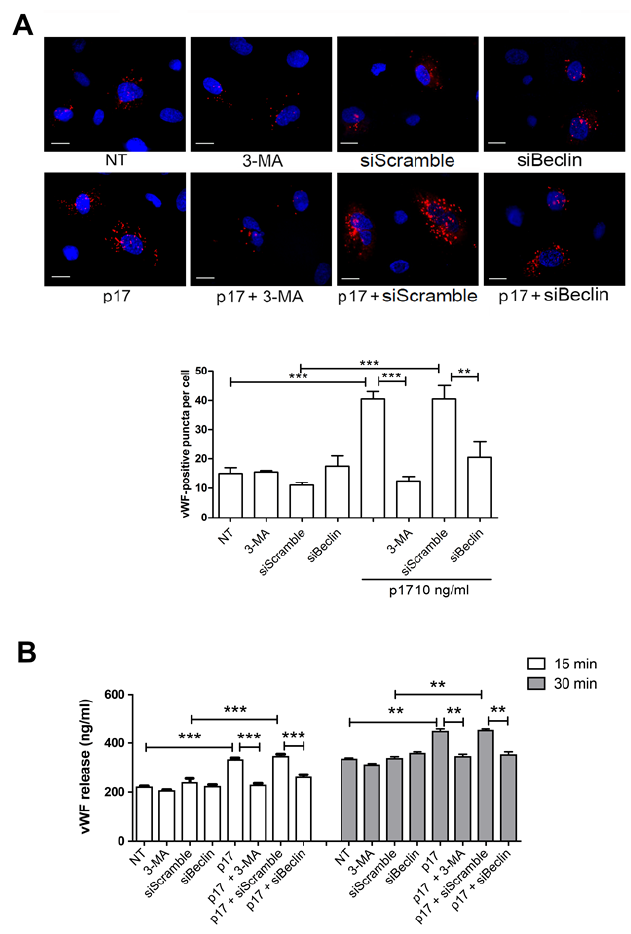
Figure 3. Inhibition of autophagy decreases p17-mediated release of vWF. ( A ) HUVECs were nucleofected with a mCherry-vWF-expressing plasmid and, when indicated, in combination with siBeclin-1 or siScramble. Twenty-four h after nucleofection, cells were serum starved for 16 h and then stimulated or not with 10 ng / mL of p17 in complete medium. When indicated, HUVECs were serum starved for 16 h in the presence or absence of 3-MA (5 mM). The images display vWF signals in red and cell nuclei in blue. Scale bar, 10 µ m. Red-positive punctate structures were counted in order to quantify the levels of WPBs. NT indicates not treated cells. Values reported for vWF positive structures are the mean ± SD of 3 independent experiments with similar results. Statistical analysis was performed by one-way ANOVA, and the Bonferroni post-test was used to compare data (** p < 0.01, *** p < 0.001). ( B ) HUVECs were serum starved for 16 h in the presence or absence of 3-MA (5 mM). When indicated, cells were nucleofected with siBeclin-1 or siScramble and serum starved 24 h after nucleofection. After serum starvation, cells were cultured in complete medium containing or not 10 ng / mL of p17. Supernatants were collected at 15 and 30 min of culture and analyzed for the presence of vWF by a standard quantitative ELISA. Bars represent the mean ± SD of triplicate samples. Statistical analysis was performed by one-way ANOVA, and Bonferroni post-test was used to compare data (** p < 0.01, *** p < 0.001). NT indicates not treated cells.